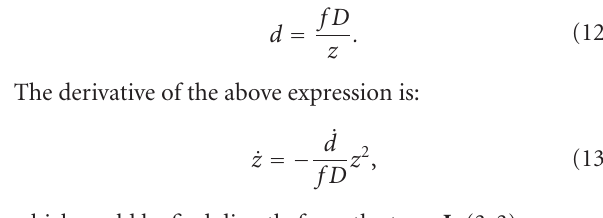
as a B´ezier curve according to (2) through points defined by image coordinates { u , v , d } . Such kind of strategy allows